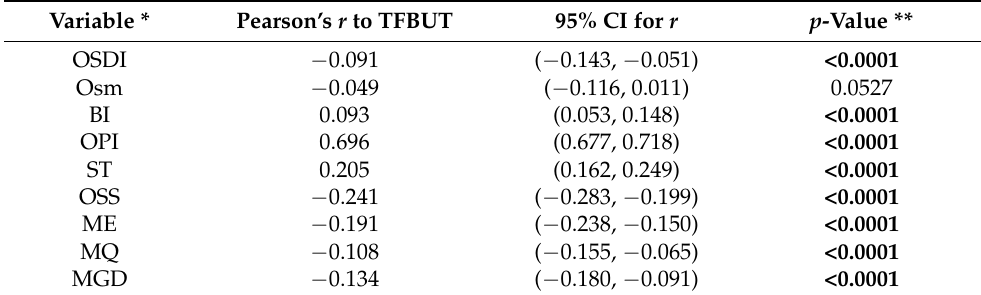
Table 6. Pearson’s correlation coefficient of determination ( r ) of TFBUT to all other clinical test.